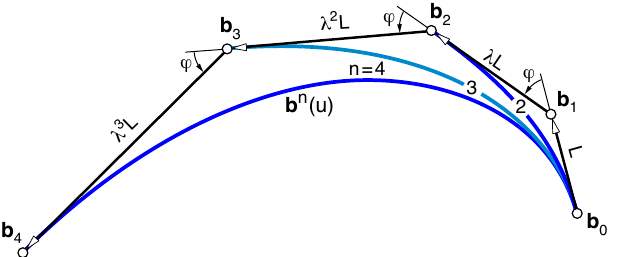
Figure 1. Dimensionless constraints { ϕ , λ } characterizing the shape of a typical Bézier curve b n ( u ) (degree n =